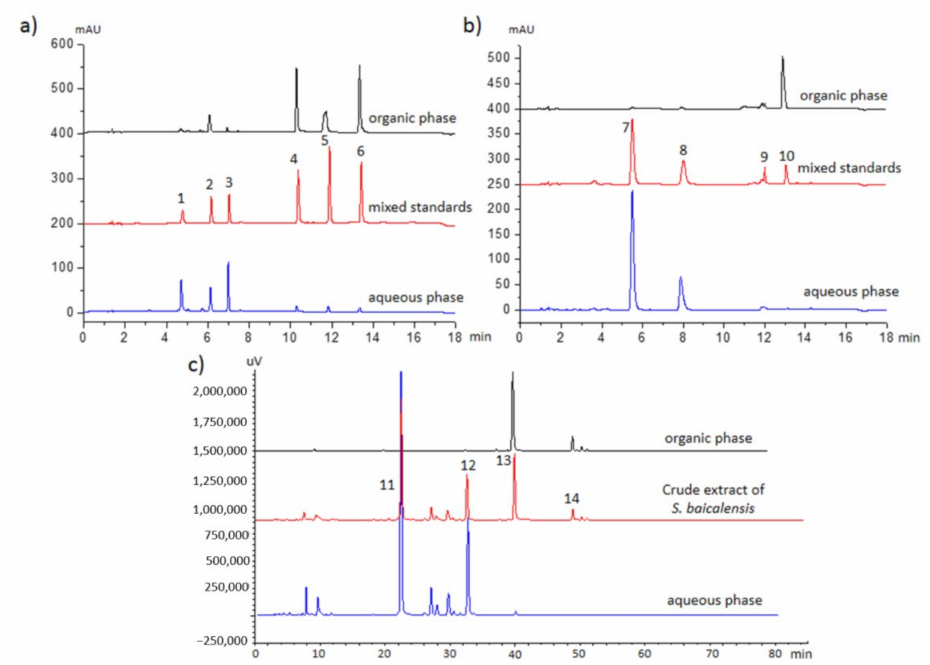
Figure 3. ( a ) HPLC profiles of the mixture of six model compounds (chlorogenic acid (peak 1), epigallocatechin gallate (peak 2), rutin (peak 3), quercetin (peak 4), santonin (peak 5) and alizarin (peak 6)), and the corresponding organic and aqueous phases collected at the outlets of the IPSE chip; ( b ) HPLC profiles of the mixture of four acidic or basic model compounds (4-hydroxybenzoic acid (peak 7), syringic acid (peak 8), emetine (peak 9), and vincamine (peak 10)) and the corresponding organic and aqueous phases collected at the outlets of the IPSE chip; ( c ) HPLC profiles of the mixture of S. baicalensis extract and the corresponding organic and aqueous phases collected at the outlets of the IPSE chip; baicalin (peak 11), wogonoside (peak 12), baicalein (peak 13), wogonin (peak 14). For structures, see Figure